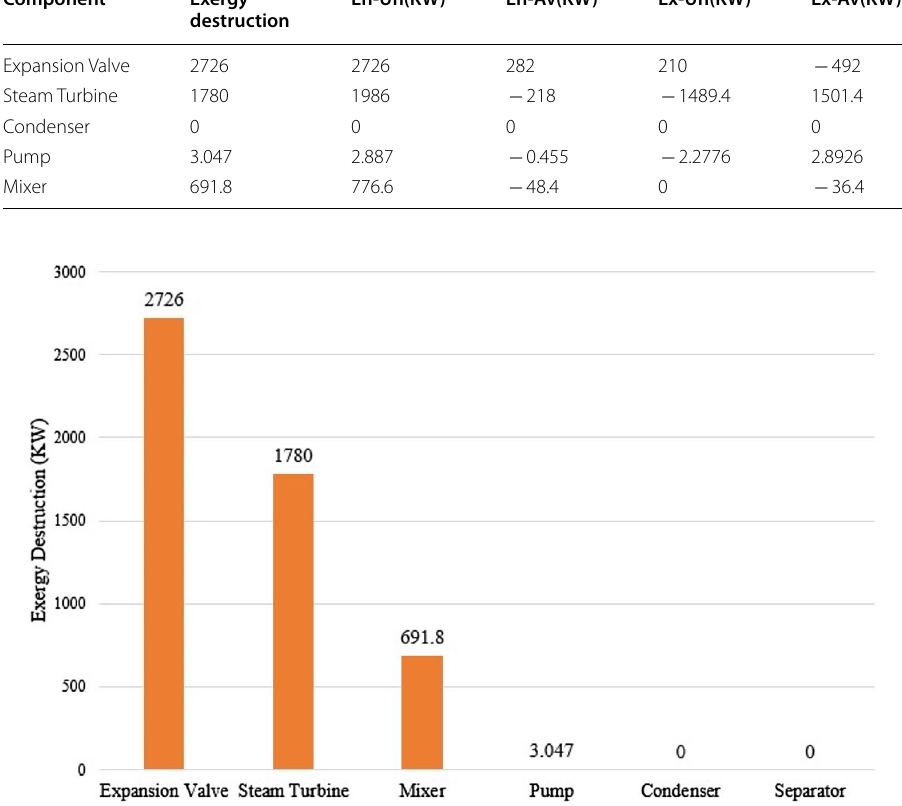
Fig. 2 Bar chart of splitting exergy destruction rates of